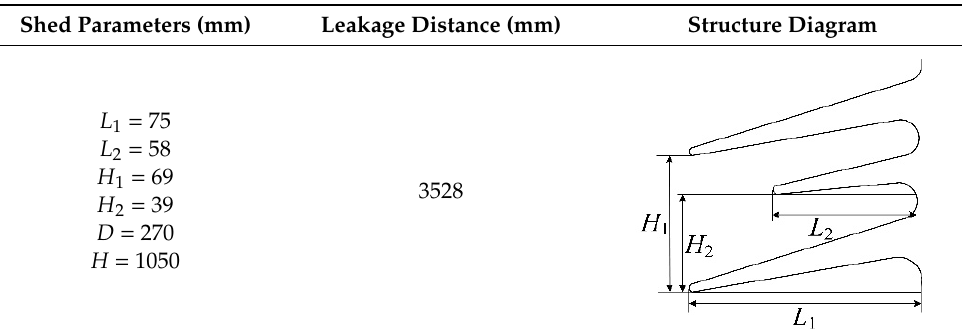
Table 1. Parameters of post insulator.